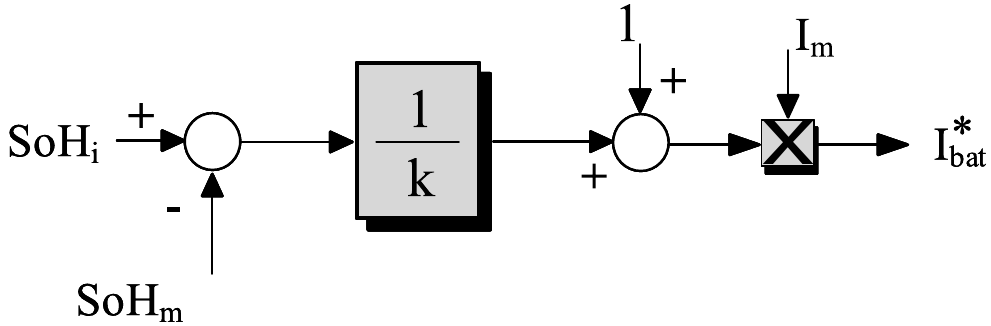
Figure 7. Block diagram of the SoH